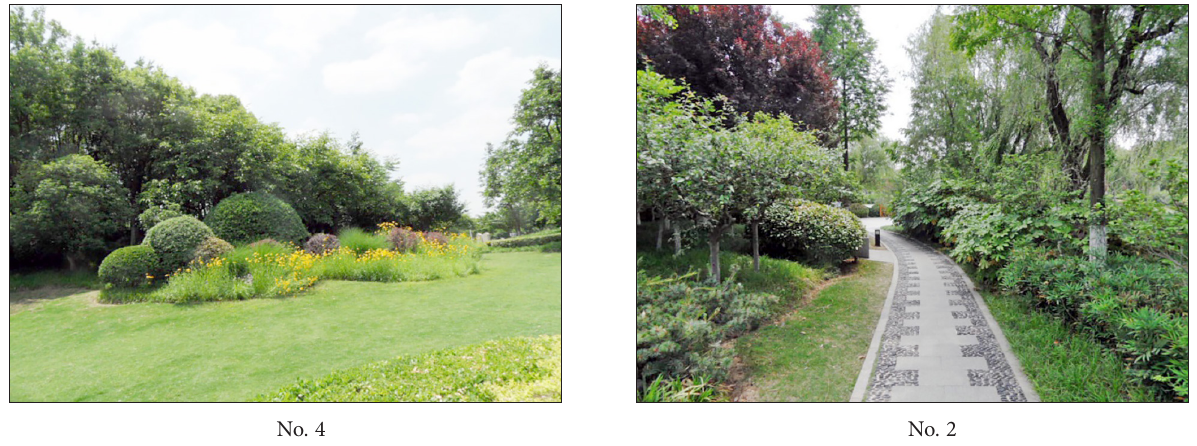
Figure 3. Photos with higher principal factor comprehensive evaluation value of plant landscape